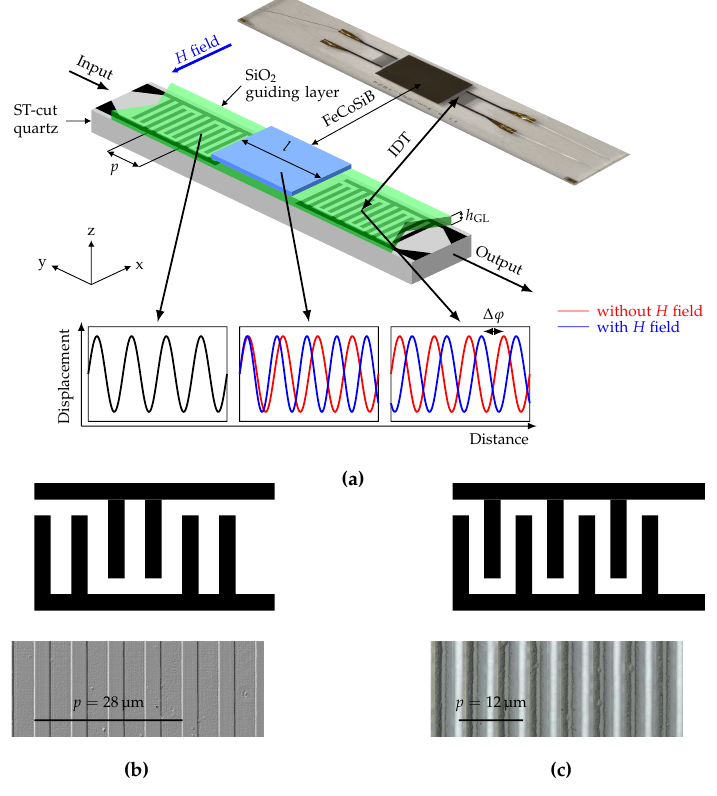
Figure 1. (a) Sensor schematic of a SAW based magnetic field delay line sensor and photograph of fabricated sensor including the materials of the different layers and important design parameters. Microscope image and schematic overview of the interdigital transducer (IDT) structure (b) for a 28µm pitch with double-finger electrodes and (c) for a 12µm pitch with single-finger electrodes. The experimental data in this study is based on the 12µm IDT pitch design. The 28µm design is included for comparison and described in more detail in [5].